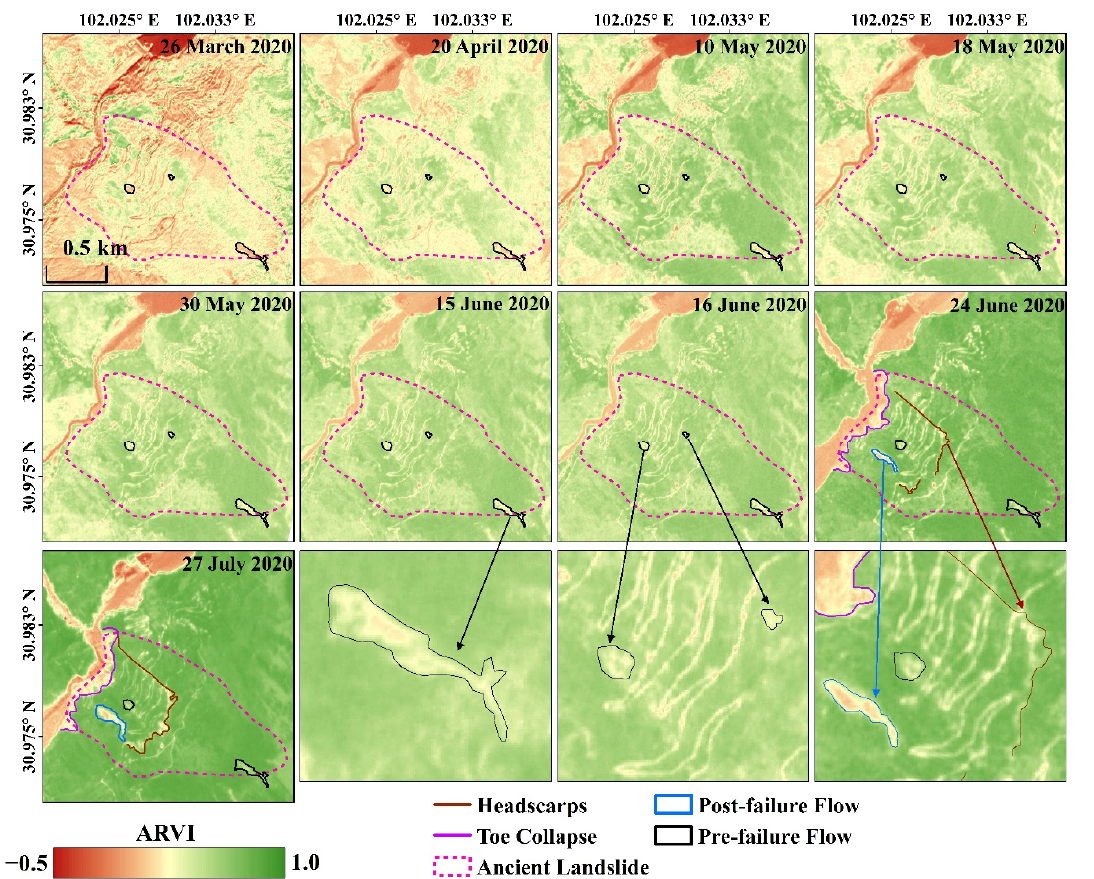
Figure 5. Time-series ARVI images derived from high-resolution optical images from the PlanetScope satellite over the ANZ landslide, with acquisition dates annotated in the upper-right corners.